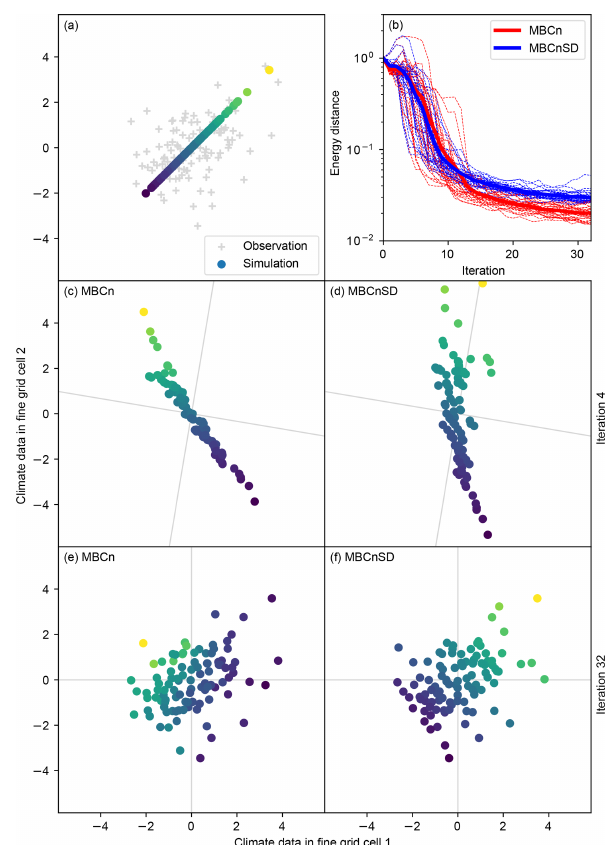
Figure 4. Statistical downscaling of artificial two-dimensional cli- mate data with the original MBCn algorithm by Cannon (2017) and the modified MBCn algorithm used for statistical downscaling in ISIMIP3 (MBCnSD). Panel (a) shows an example of observation and simulation data drawn from a bivariate standard normal distri- bution with cross-correlation 0 and 1, respectively. Panels (c) – (f) show the result of statistical downscaling after 4 (c, d) and 32 (e, f) iterations of the MBCn (c, e) and MBCnSD (d, f) algorithm. To track changes, the color of a data point in panels (c) – (f) is the same as the color of the corresponding original data point in panel (a) . Gray lines in panels (c) – (f) represent the axes along which univari- ate quantile mappings are applied in the respective iteration. Note that MBCn and MBCnSD use the same sequence of axes rotations here. Panel (b) shows the energy distance (Székely and Rizzo, 2013) between observation and simulation data over iterations for 30 ran- dom data samples (thin dashed lines) and on average over these 30 samples (thick solid